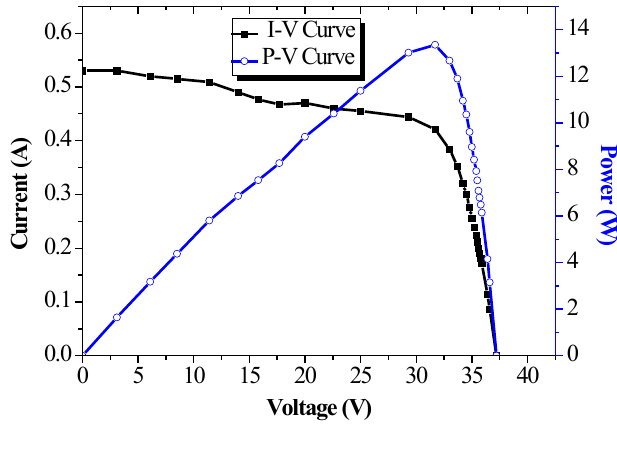
Figure 6. I-V and P-V curves of solar PV array under non-shading